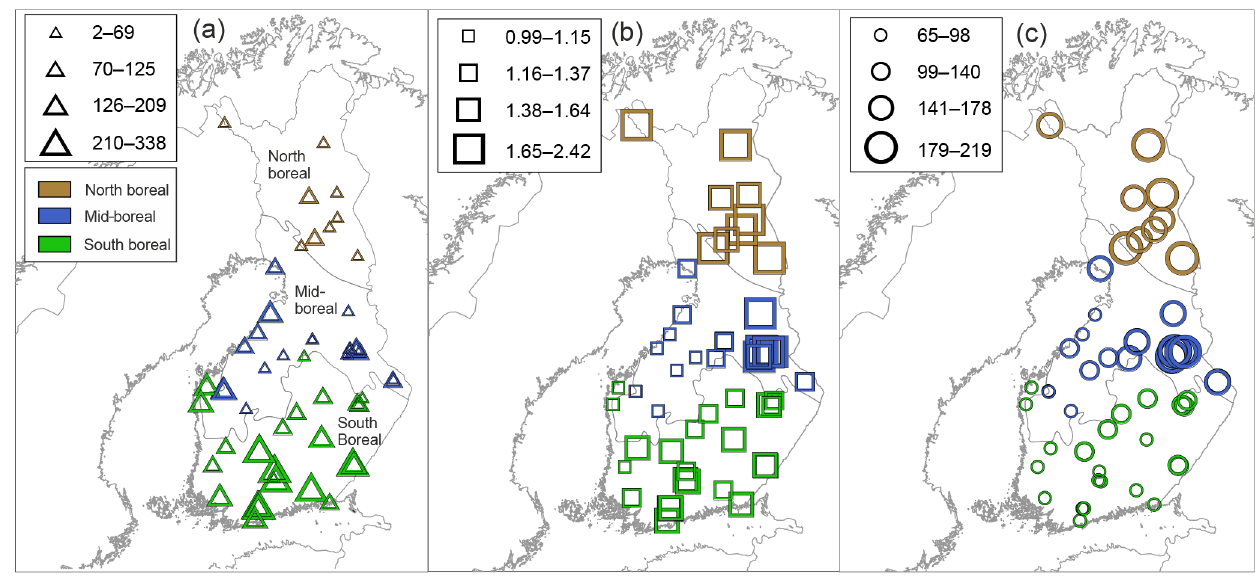
Figure 3. Map with study catchments and (a) calculated root zone storage values ( S r , mm), (b) ratio of precipitation and potential evaporation, and (c) maximum snow water equivalent ( S SWE , mm). Different boreal ecoregions (south boreal, mid-boreal and north boreal) are shown in the colours of the symbols and boundaries of ecoregions are marked with grey lines.